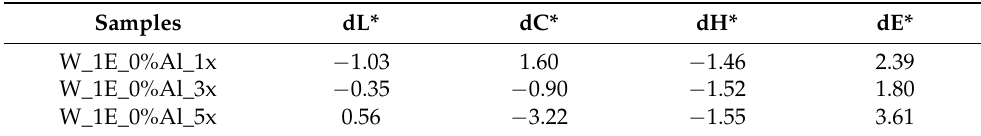
Table 15. Change in color coordinates of wool sample dyed with SJL aqueous extract without mordants after 1st, 3rd and 5th washing cycle (compared with W_1E_0%Al_0x).